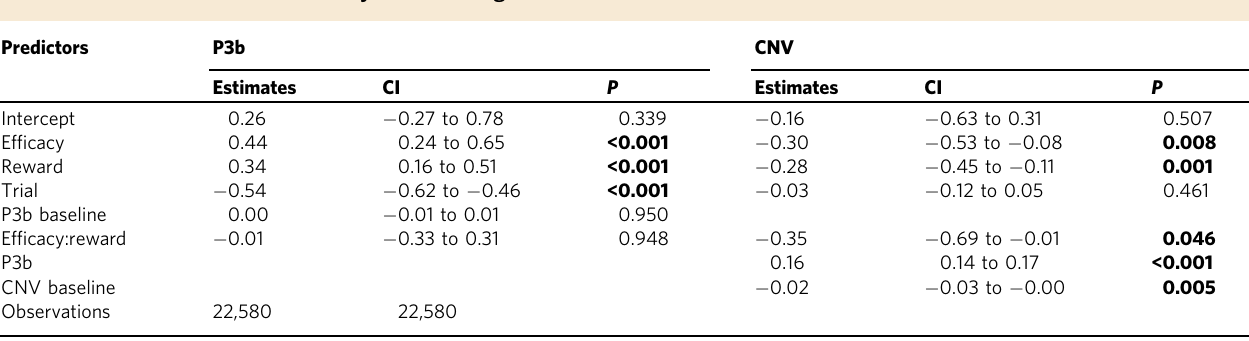
Table 1 Effects of reward and ef fi cacy on neural